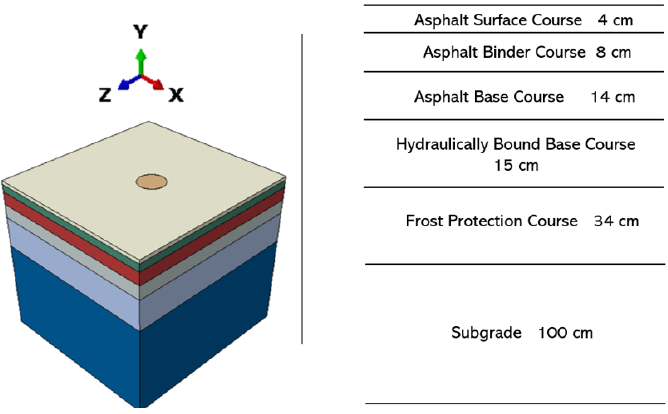
Figure 2. Asphalt pavement model in ABAQUS.